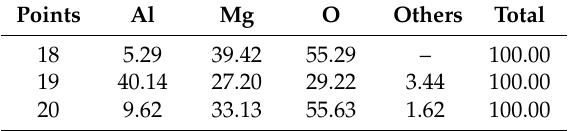
Figure 10. Corrosion morphologies of the Al/Mg joint in the 3.5% NaCl solution for 60 h: ( a ) overview and ( b – d ) magnified views of the R13, R14, and R15, respectively. Table 7. Elemental compositions (in wt.%) of points 18–20 in Figure 10b–d.